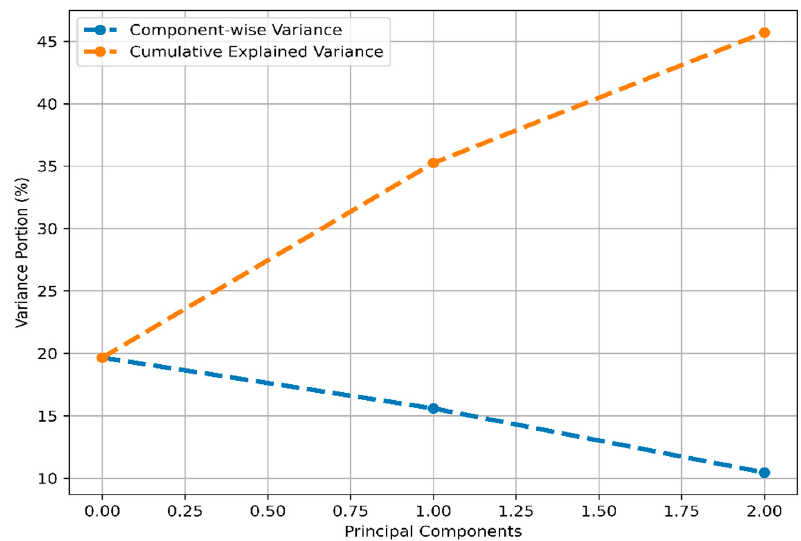
Figure 7. Individual and cumulative variance of the principal components.